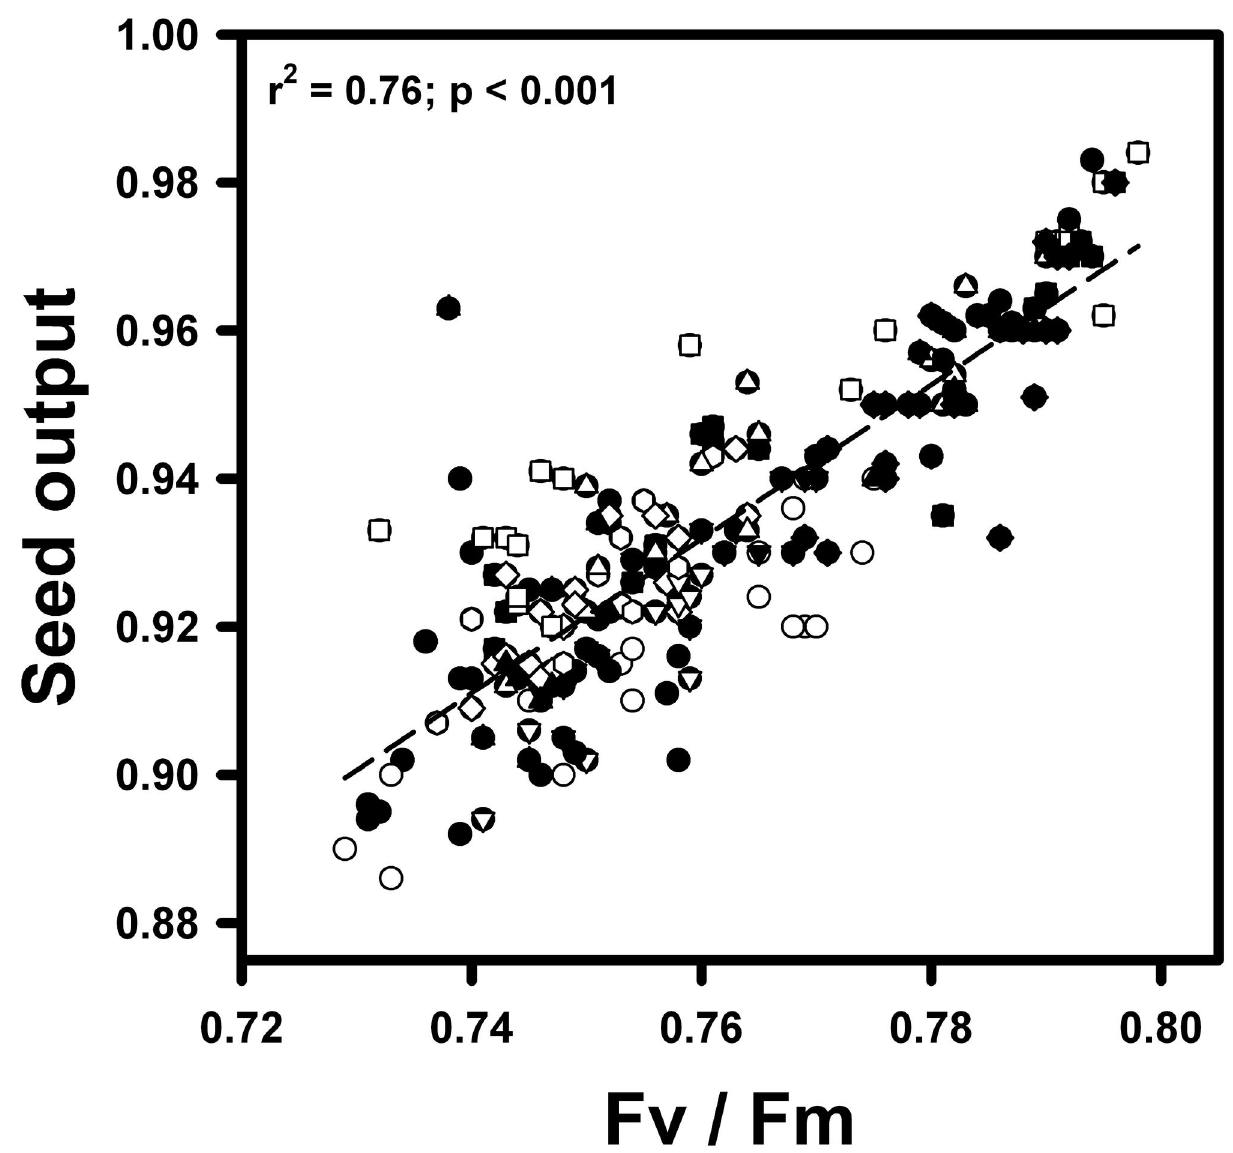
Figure 2. Relationship between maximum quantum yield (Fv / Fm) and seed output for 12 Taraxacum officinale individuals from 17 different localities distributed at worldwide. Combination of shape and color indicates different localities (total n = 204